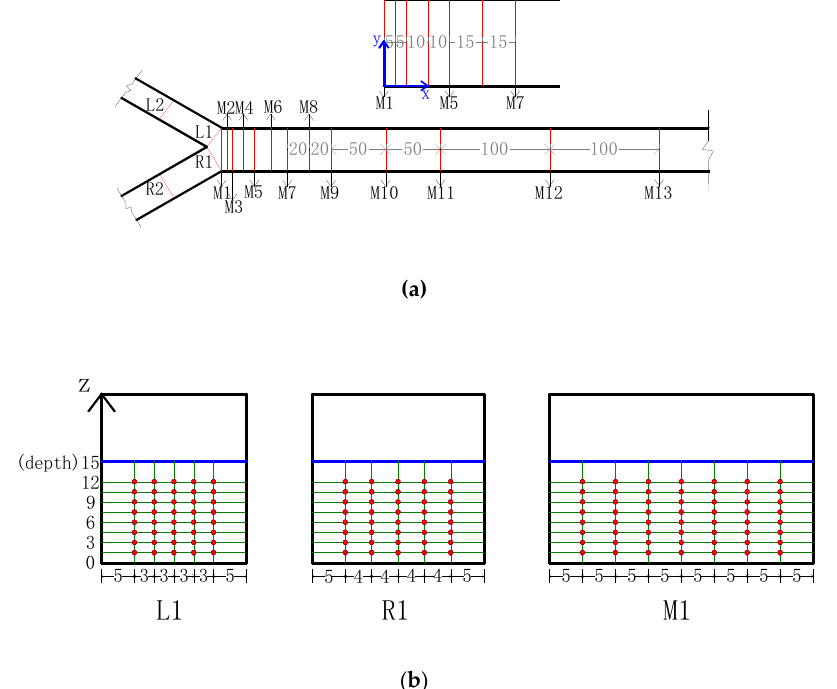
Figure 4. Location of: ( a ) Cross sections; ( b ) Flow velocity measurements.